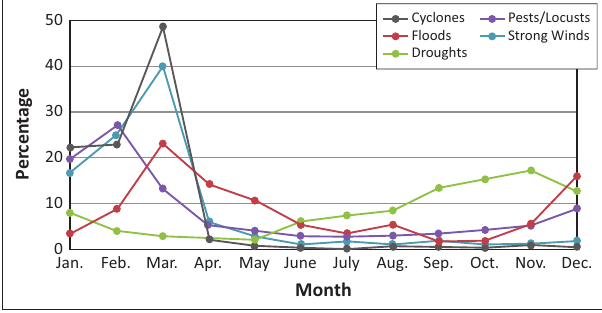
FIGURE 2: Occurrence of hazards likely to occur in Malawi according to month.